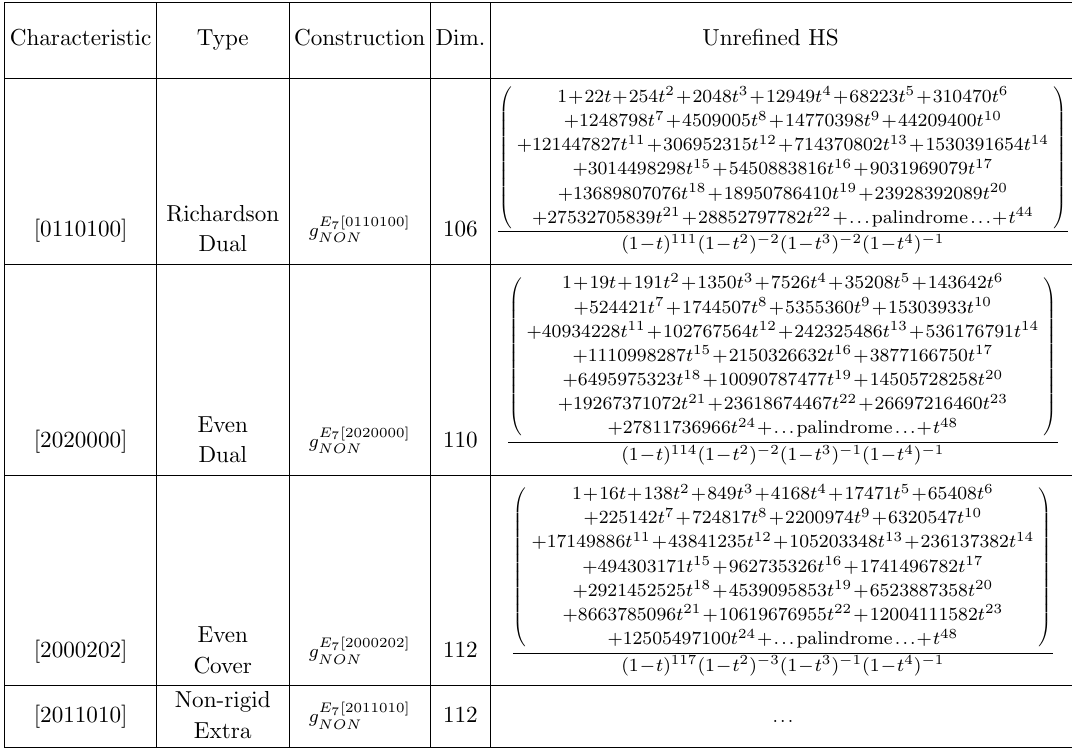
Table 27 . E 7 extra moduli spaces and Hilbert series (B). These moduli spaces are associated with SU(2) homomorphisms but do not represent additional nilpotent orbits (see text).